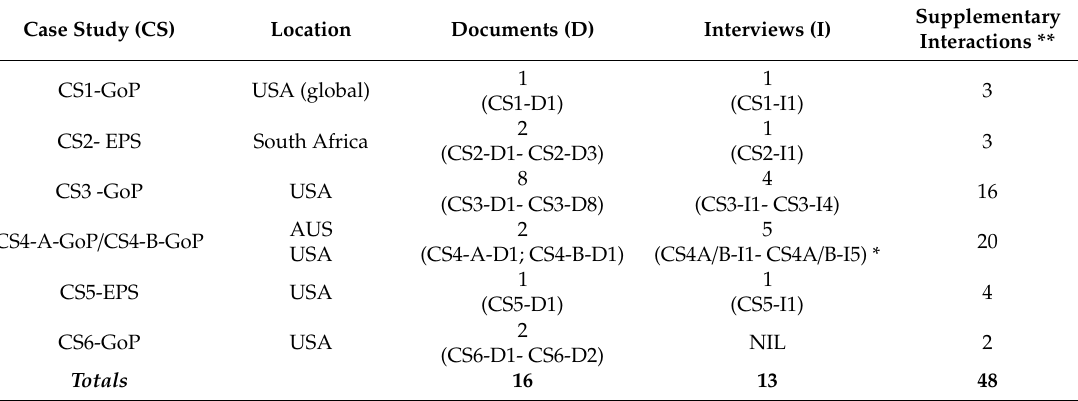
Table 1. Summary of case-study data